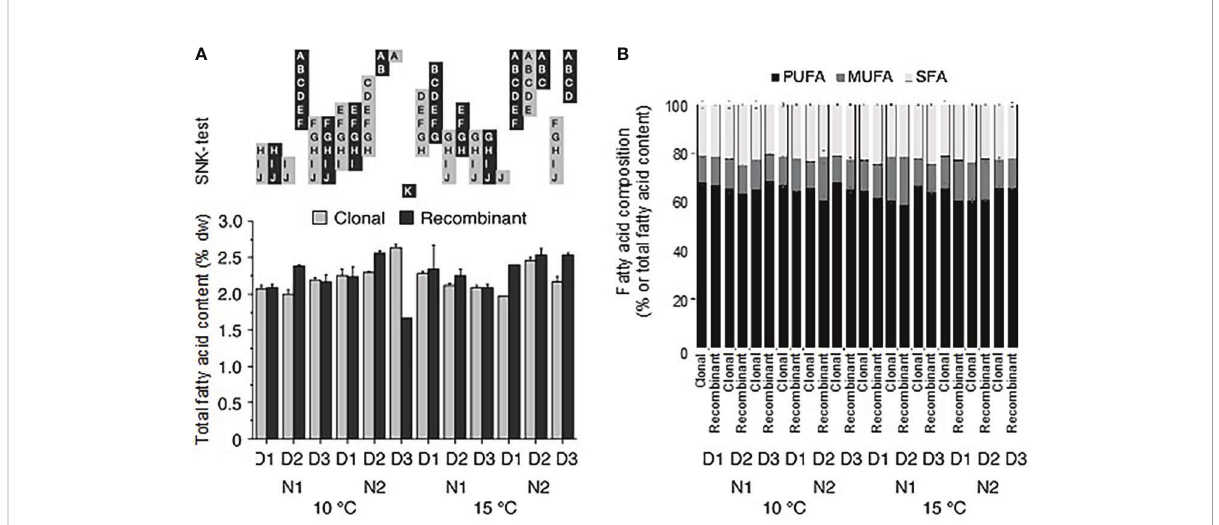
FIGURE 5 Ulva fatty acid content and composition. (A) Total fatty acid content (% dw) and (B) the distribution of different fatty acid classes (PUFA, MUFA, and SFA) in Ulva fenestrata clonal and recombinant gametophytes after 12 weeks culture under different environmental conditions (10°C and 15° C, N1 = PES and N2 = 3xPES, D1 = 10 000 swarmers ml -1 , D2 = 5000 swarmers ml -1 and D3 = 500 swarmers ml -1 , for further explanations see text). Letters above bars denote signi fi cant differences based on the Student Newman Keul´s (SNK) post hoc test. Treatments with non- overlapping letters are signi fi cantly different (SNK, p < 0.05). Error bars show + SEM (n = 2).